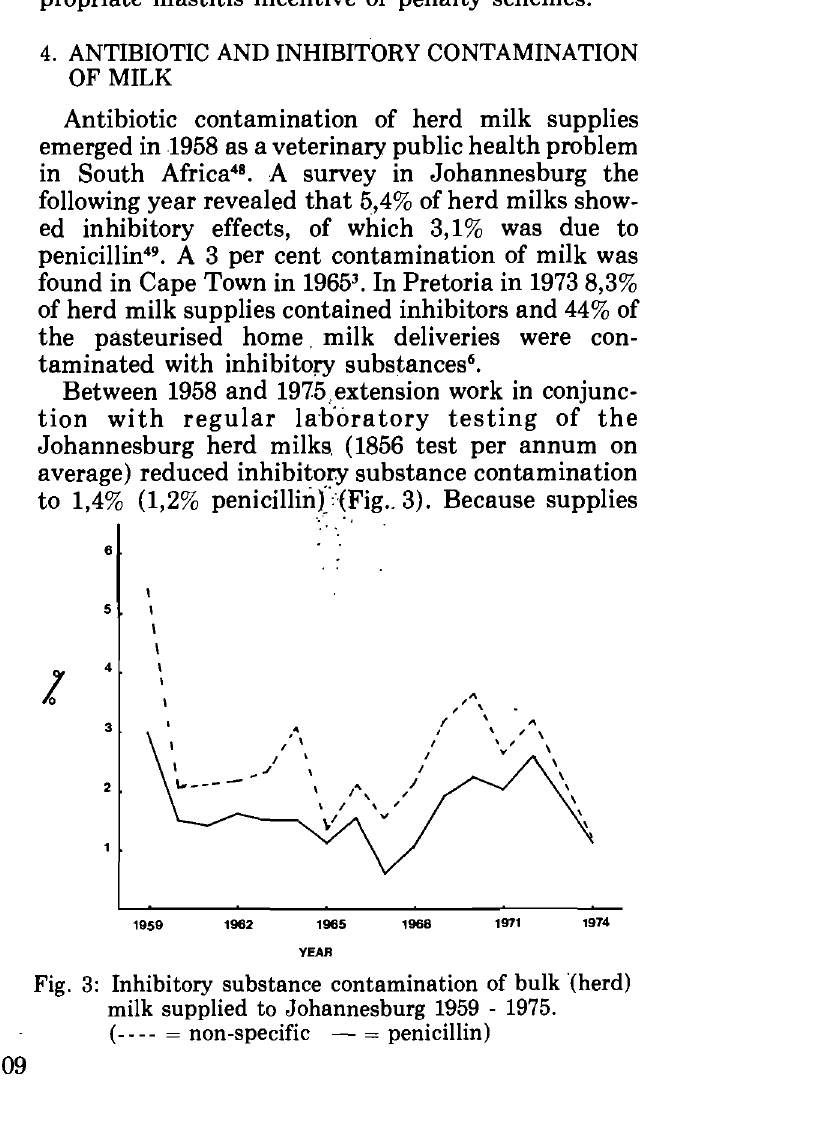
Fig. 3: Inhibitory substance contamination of bulk '(herd) milk supplied to Johannesburg 1959 -